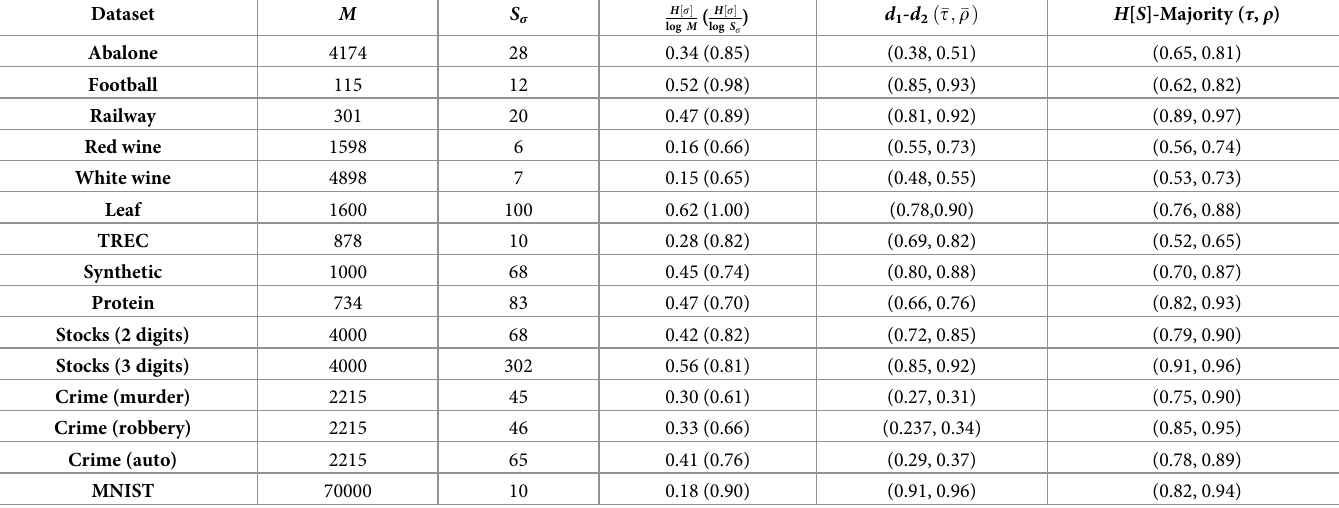
Table 1. Quantitative description of data sets: M is the number of points, H [ σ ] is the entropy of the ground truth classification. d 1 — d 2 represents the conformity among the different goodness metrics (purity, NMI and ARI) in terms of Kendall’s � t and Spearman’s � r rank correlation (see text). The last column reports the Kendall’s τ and Spearman’s ρ rank correlations of ^ H ½ s � with the majority ranking of similarity to the ground truth (see text).